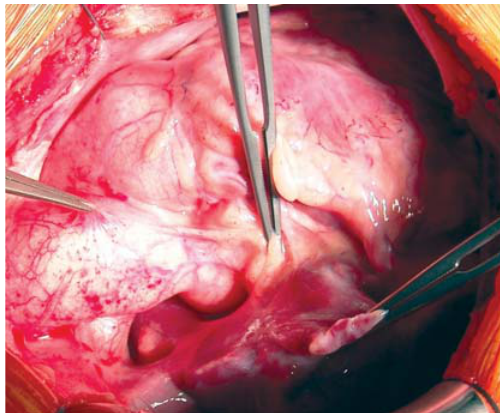
Fig. 2 – Aspecto externo do local de estreitamento na aorta ascendente